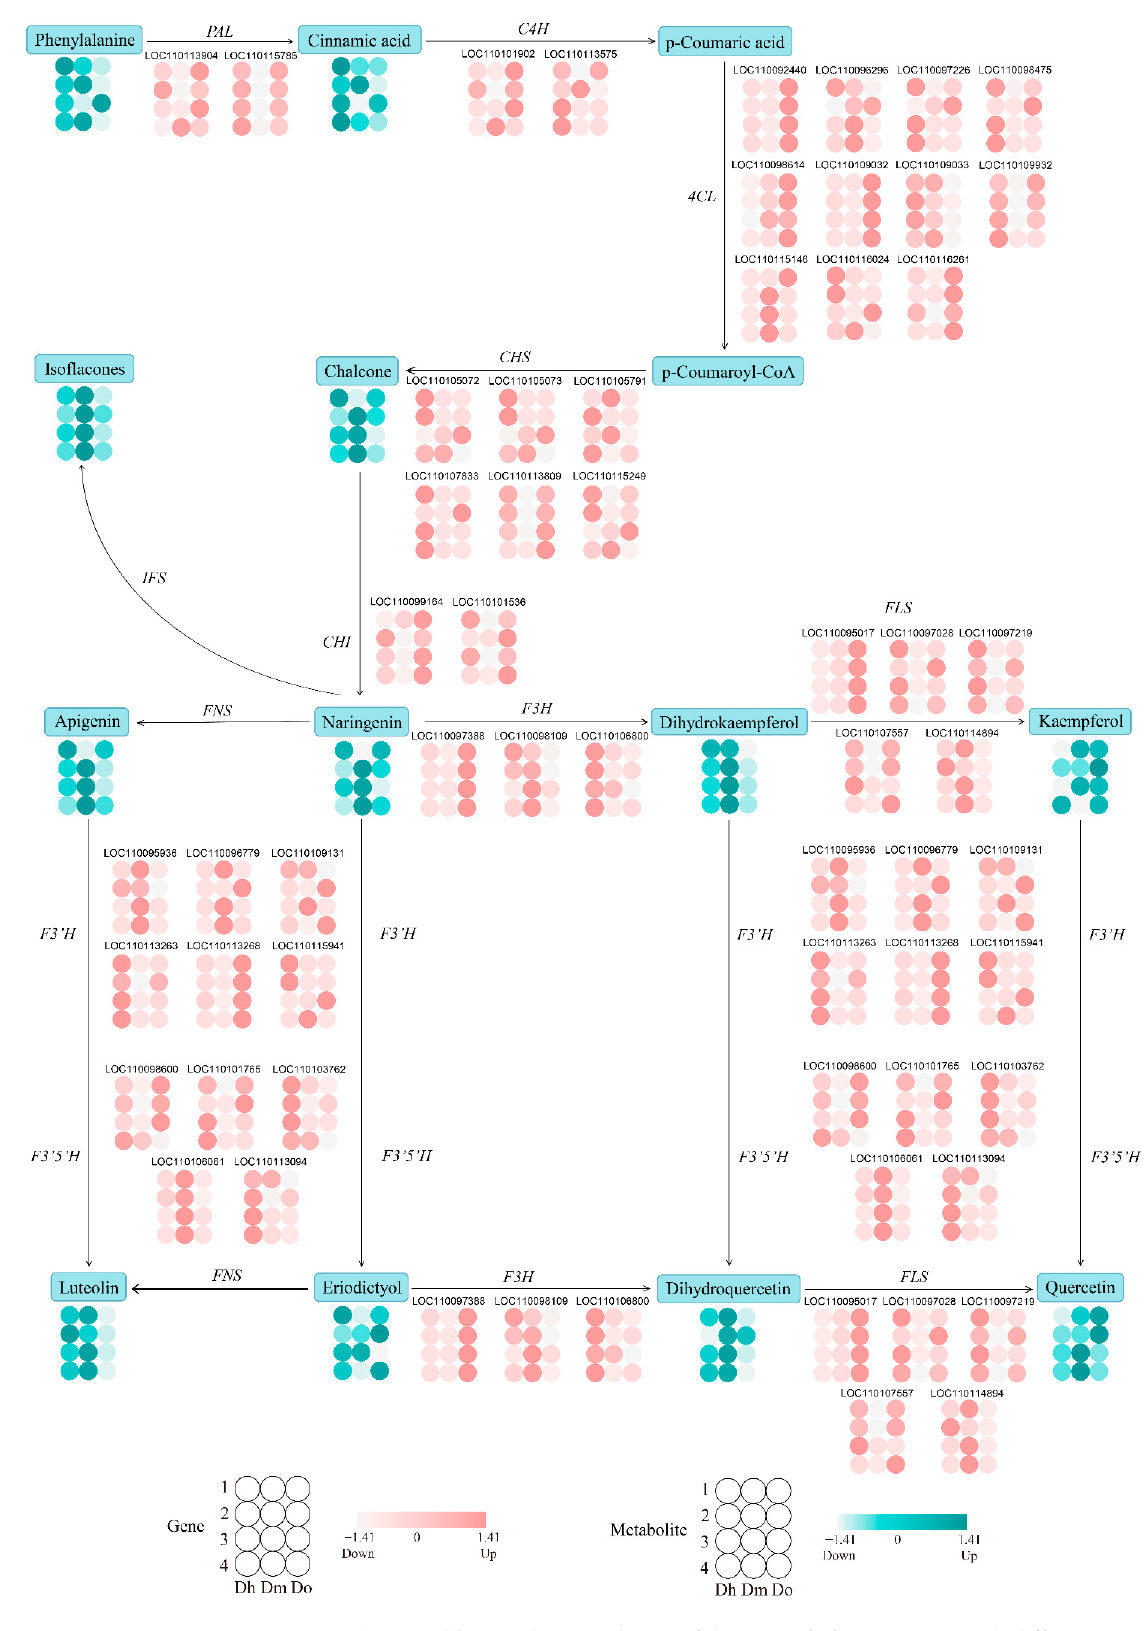
Figure 7. Flavonoid biosynthesis pathway of three Dendrobium species with different growth years. The four rows and three columns of circular patterns indicate the corresponding growth years and expression levels of Dendrobium species, respectively. Red represents DEGs and green represents DAMs.